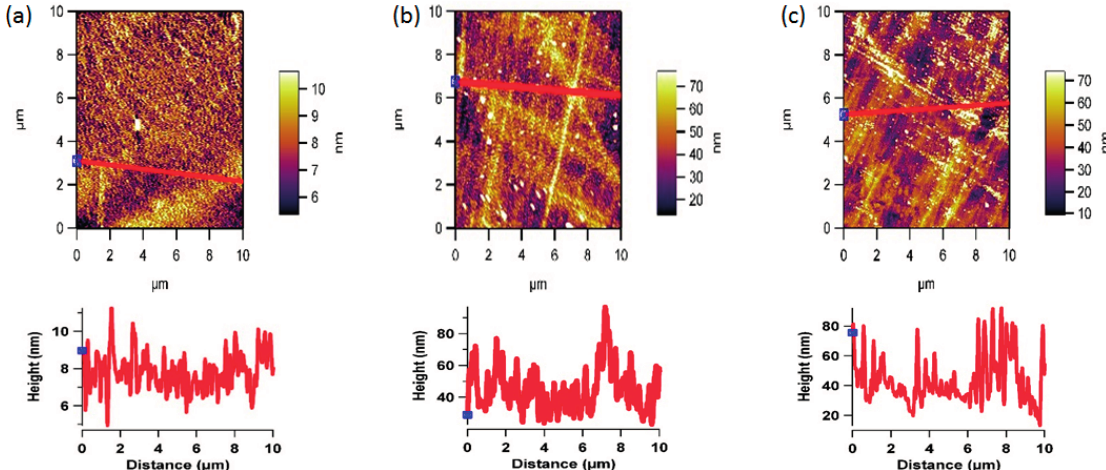
Figure 7. Representative 2D non-contact mode AFM images (10 µm × 10 µm) and line profiles for PC after ( a ) 10, ( b ) 20, and ( c ) 30 min of oxygen plasma